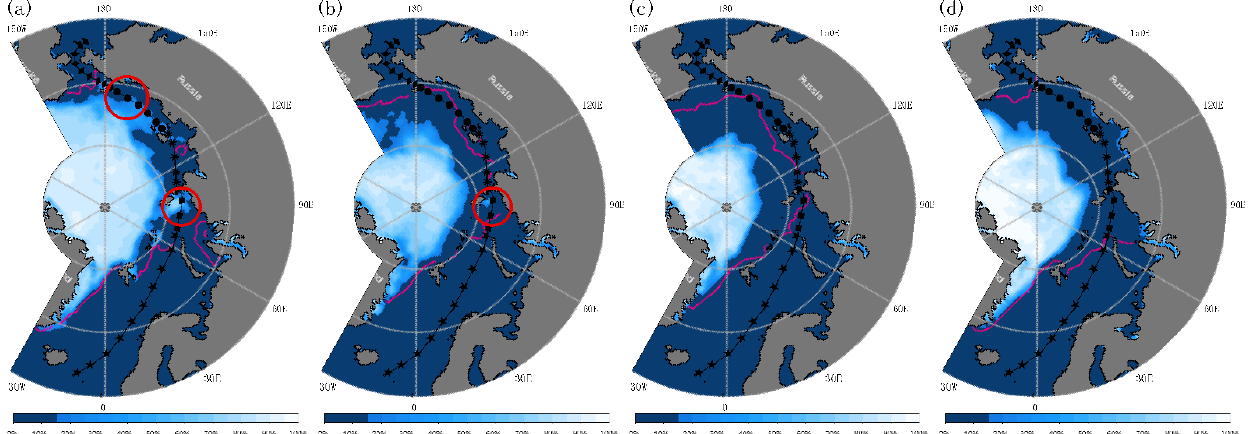
Figure 7. Spatial distribution map of sea ice concentration from July to October 2020 ( a – d ). (The red circles represent the special areas, the red line is the average sea ice edge line for each month from 1981 to 2010.).